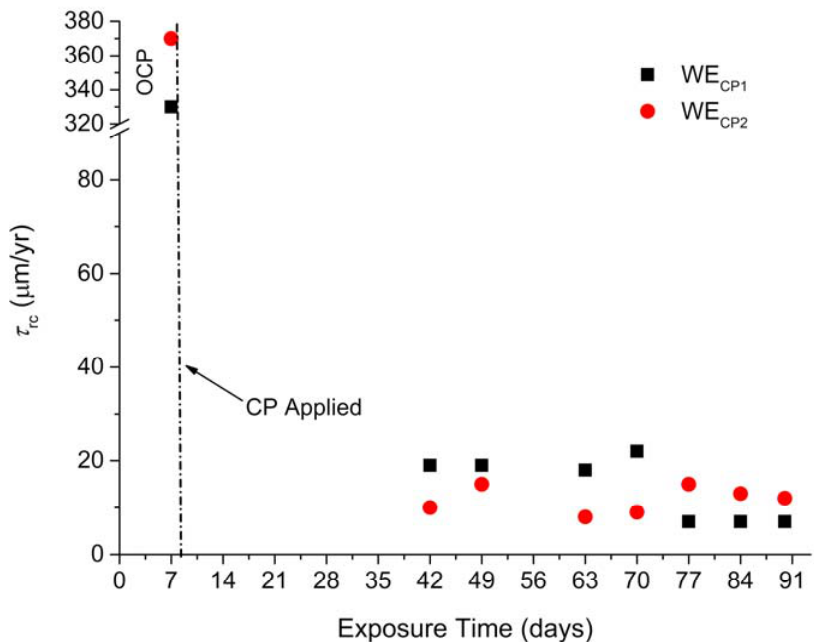
Figure 11. Evolution of the residual corrosion rate over time for coupons WE CP1 and WE CP2 . Two different behaviors were also observed via EIS, in particular for the evolution of R s over time (Figure 2). For coupon WE CP1 , the R s value remained constant after day 42, which indicates that the steel/soil interface has reached a steady state. Conversely, for cou ‐ pon WE CP2 , R s , after an initial decrease until day 21, tended to increase regularly with time. This increase of R s could be associated with a slight decrease of the “wet” or “active” area of the steel electrode [10,11,25,26]. This decrease of the active area could be due to the accumulation of H 2 bubbles on the surface. The release of such bubbles from time to time would then damage the protective film and lead to the observed increase of τ rc .